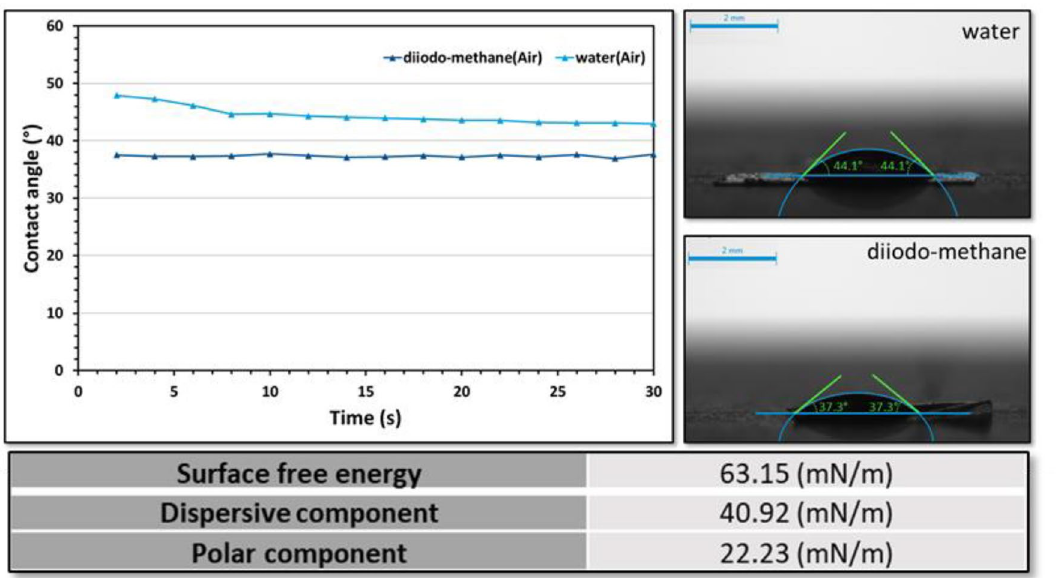
Figure 5. Water and diiodomethane contact angles and calculated surface free